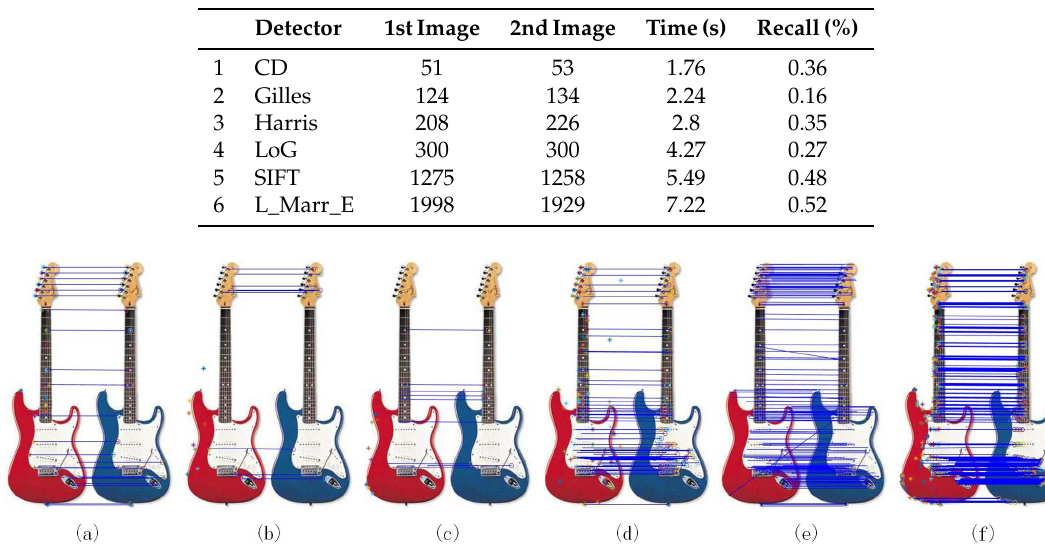
Table 4. Feature point matching results under different kinds of algorithms.